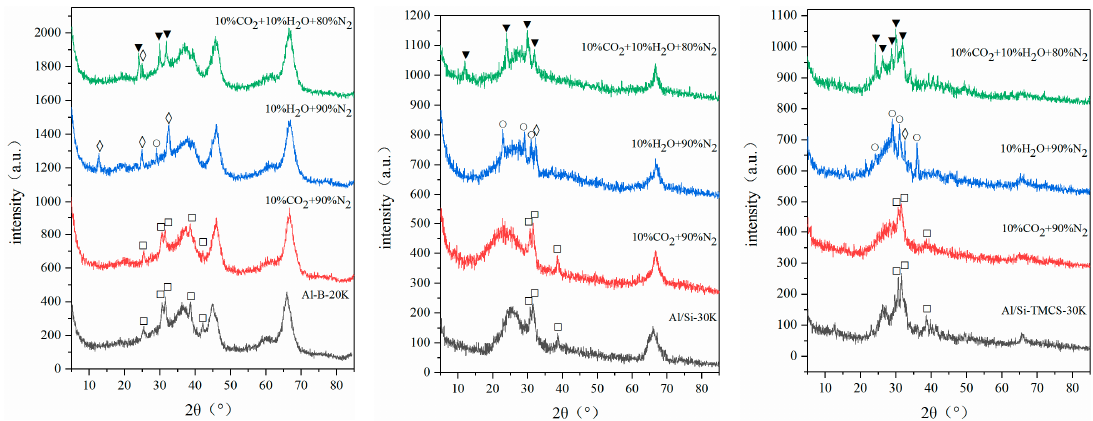
Figure 8. XRD spectra of K 2 CO 3 -based adsorbent in different atmospheres. —K 2 CO 3 , ◊ —K 2 CO 3 ·1.5 H 2 O, ο —K 4 H 2 (CO 3 ) 3 ·1.5 H 2 O, ▼ —KHCO 3 .